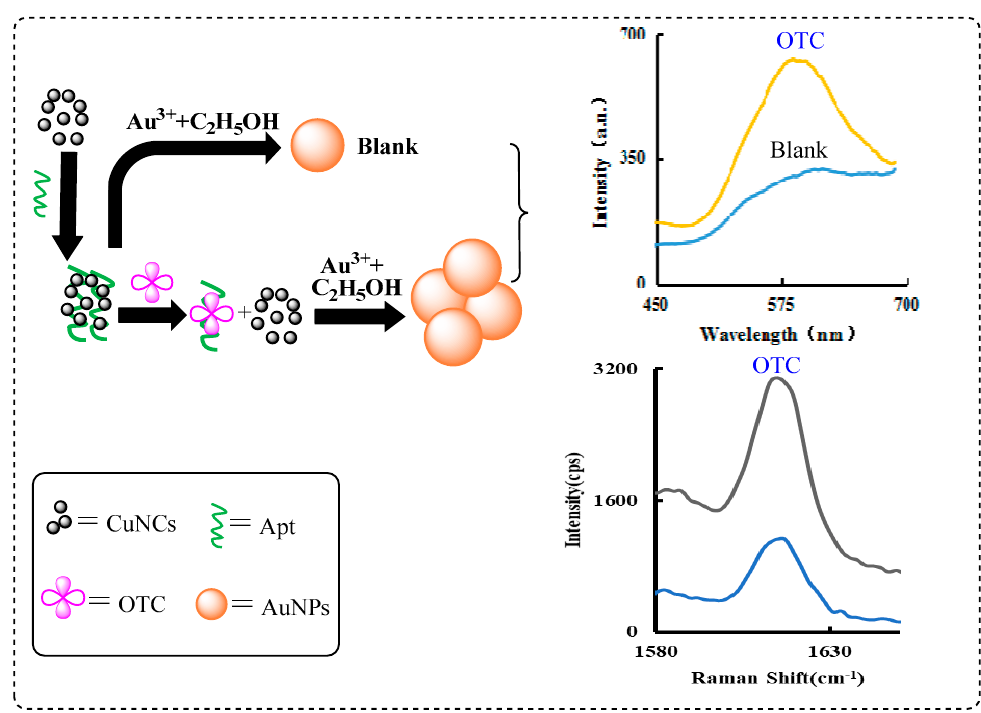
Figure 1. Schematic diagram of RRS/SERS assay of OTC based on Apt controlling CuNCs catalysis.